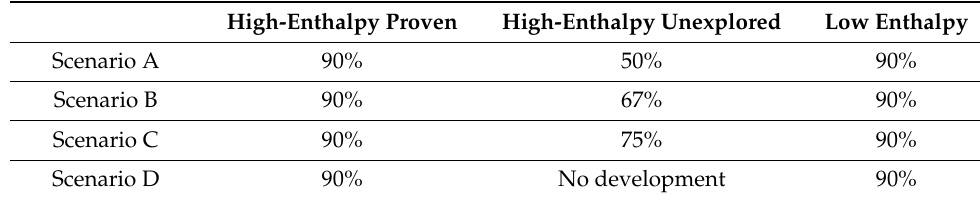
Table 3. Success rate per geothermal field type. High-Enthalpy Proven High-Enthalpy Unexplored Low Enthalpy Scenario